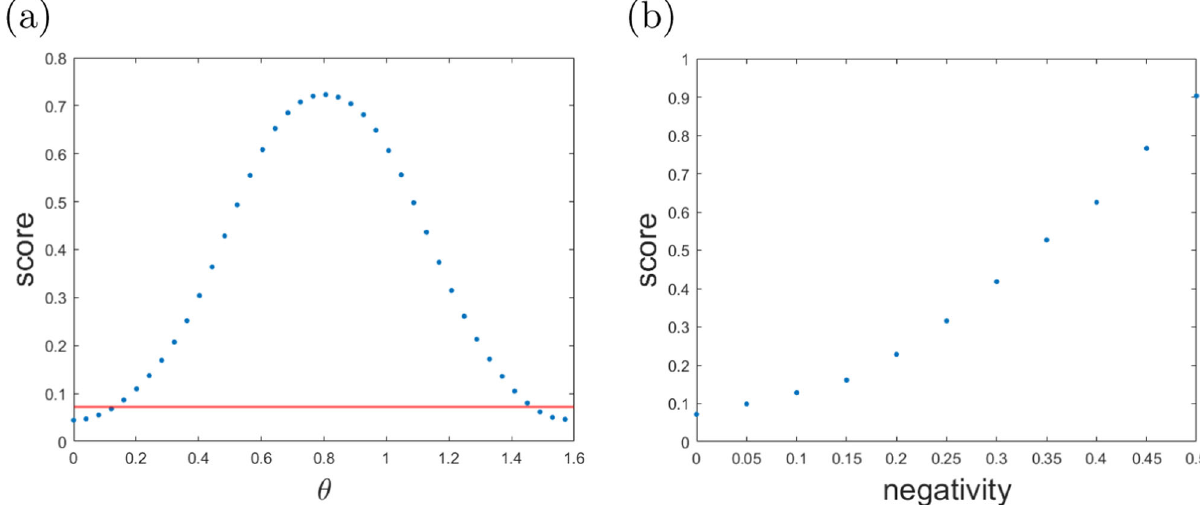
Fig. 6 Gradient descent based preparation game. The parameters are taken to be ϵ = 0.1, λ = 0.1 and θ 0 = 0. The probability of measuring M 0 round k is chosen according to p k ð 0 Þ ¼ 1 . This captures the intuition that in the fi rst few rounds it is more important to adjust the angle, while in later 1 þ e (cid:7)ð 2 k (cid:7) n Þ rounds the witness should be measured more often. a The score assigned to i.i.d. preparation strategies as a function of the parameter θ of ψ θ rounds for E (blue) compared to the optimal separable value (red). As expected, the average game scores of the i.i.d. strategies f ψ θ shape of the curve h ð cos 2 ð θ ÞÞ and the scores obtainable with the set of separable strategies S perform signi fi cantly worse compared to the states from E with angles close to θ ¼ π . b The optimal scores achievable by players capable of preparing bipartite quantum states of bounded negativity 30 , obtained 4 through application of eq. (2). We observe that the average score of the game constitutes a good estimator for entanglement normal distribution. For e < μ (cid:2) v , this leads to a scaling as I m m ð μ (cid:7) eI Þ 2 ð m Þ (cid:12) e (cid:7) e 2eI ð 1 (cid:7) eI Þ (similarly for (1 − e II ) when μ < 1 − e II , and I